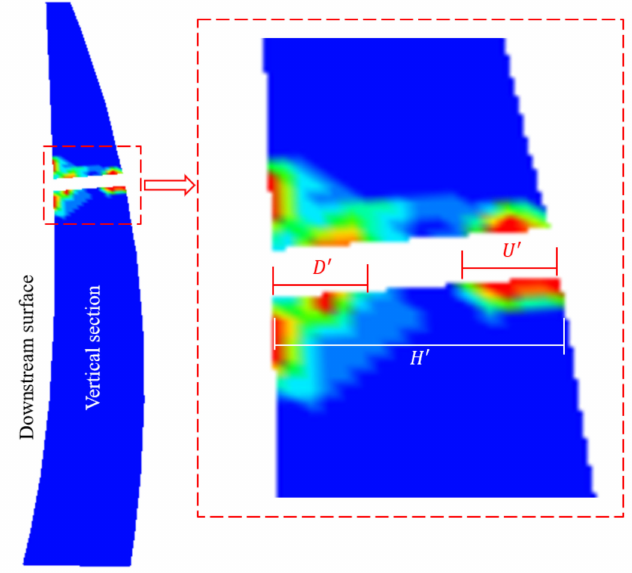
Figure 4. Parameters of local damage for the deep flood discharge